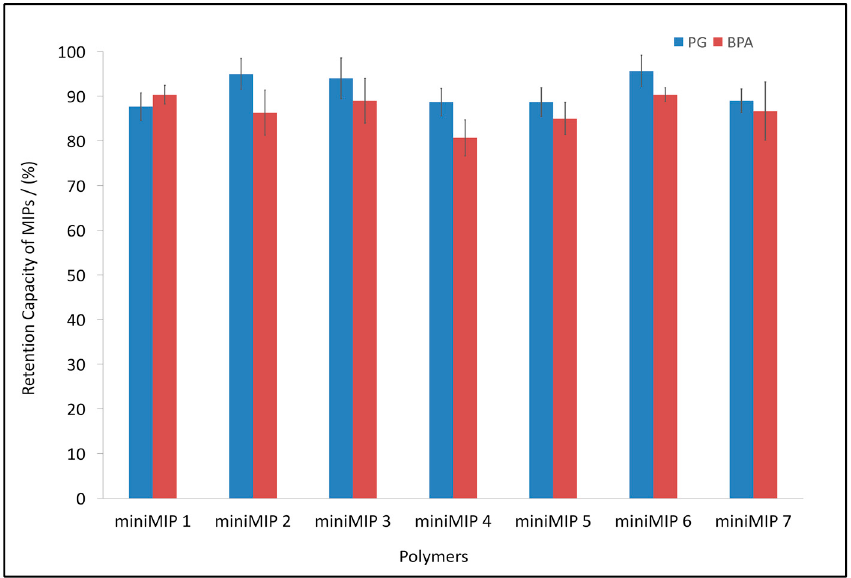
Figure 4. PG and BPA retention capacities of miniMIPs; an initial concentration of PG (5.28 mg/L), initial concentration of BPA (3.12 mg/L), and 50 mg of miniMIPs synthesised according to the experimental design. Error bars represent ±1 standard deviation. Experiments were performed in triplicate.